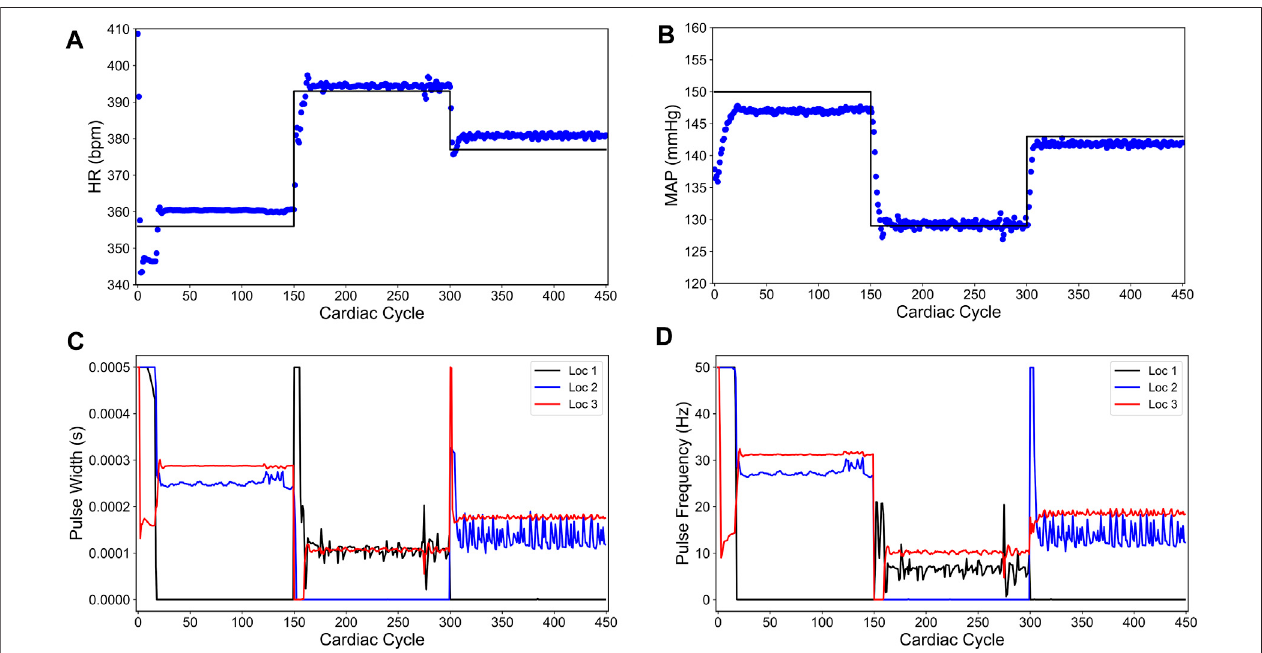
FIGURE7| Sparsity-promotedclosed-loopcontroloftheheartrate(HR)andthemeanarterialbloodpressure(MAP)ofthemodi fi ed insilico physiologicalmodelof the rat cardiac system. (A) and (B) show the closed-loop control response from the modi fi ed in silico physiological model (shown in blue dots) and the target (or reference)forthecontroller(showninblackline)forHRandMAP,respectively. (C) and (D) showthepulsewidthandthestimulationfrequency,respectively,designedby the controller at each VNS location.